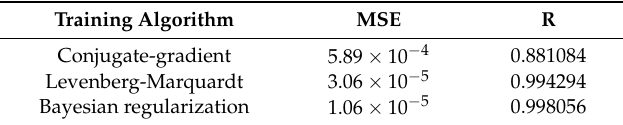
Table 3. Testing training algorithms with independent samples.